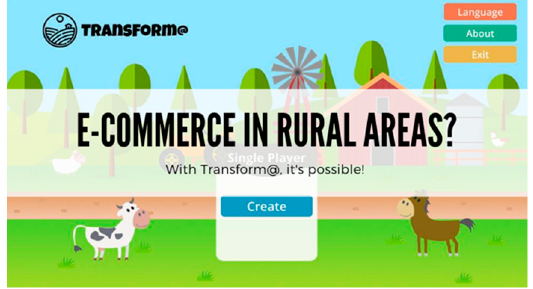
Figure 2. Transform@ entry screen.